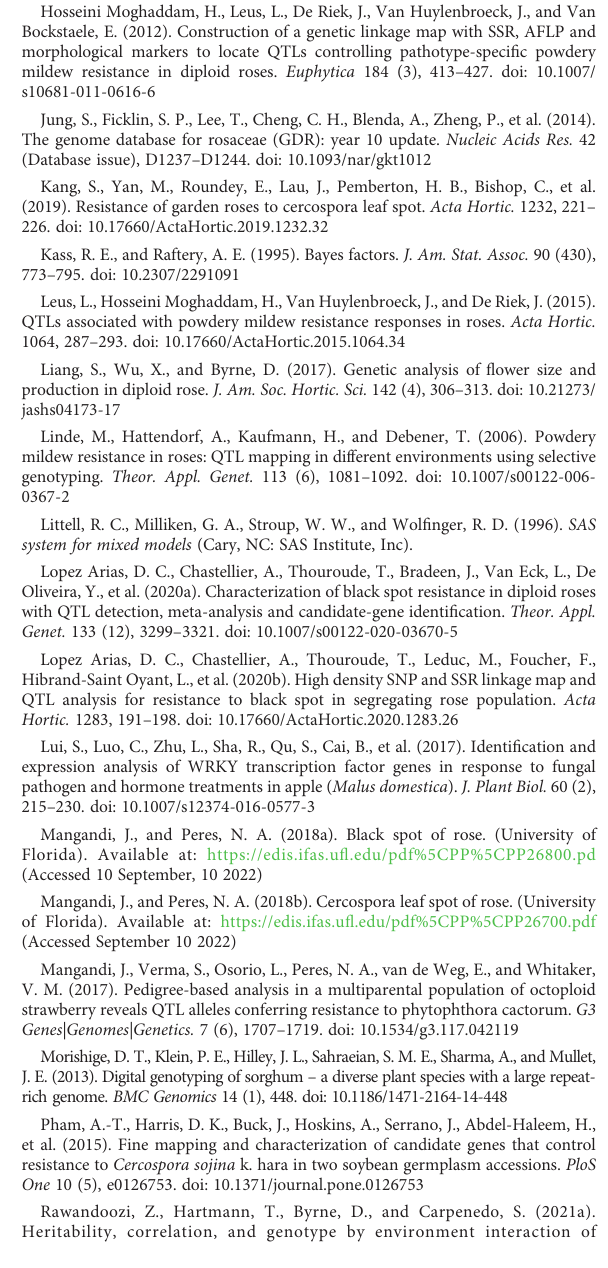
SUPPLEMENTARY FIGURE 12 Probable QTL genotype at the signal peak from all progenies for cercospora leaf spot QTLs of diploid rose populations qCLS.TX2WOB- LG3.2 (A) and qCLS.TX2WOB-LG4.2 (B) for TX2WOB and qCLS.TX2WSE- LG3.1 (C) and qCLS.TX2WSE-LG6.2 (D) for TX2WSE.